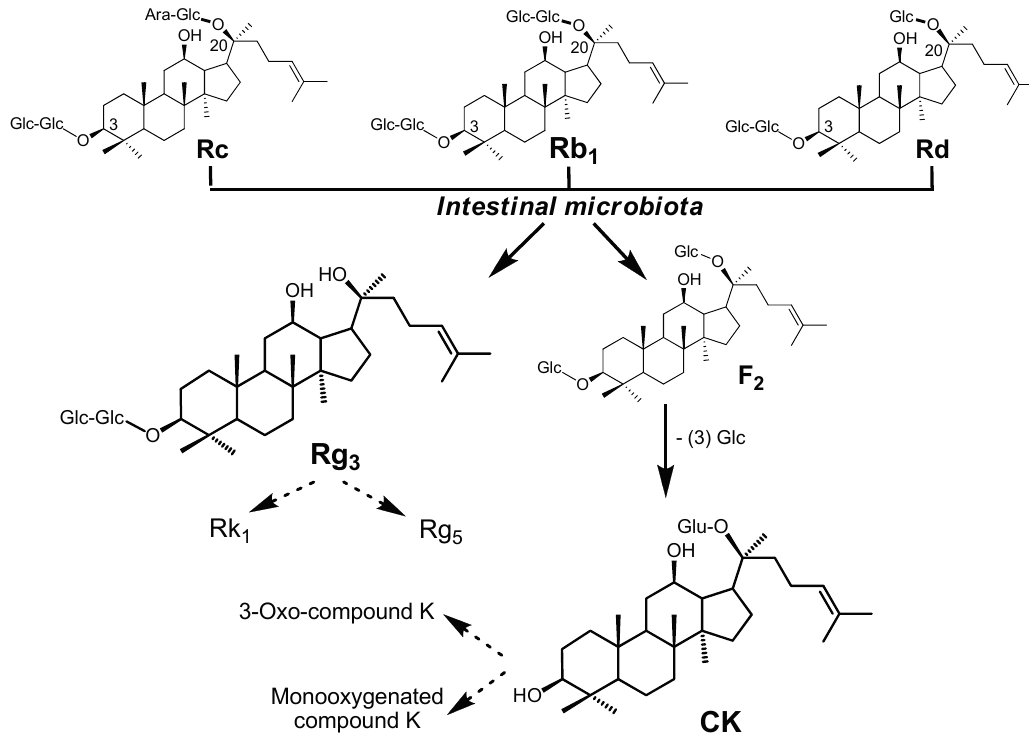
Figure 2. Metabolic pathways of PPD group ginseng saponins converted by the intestinal